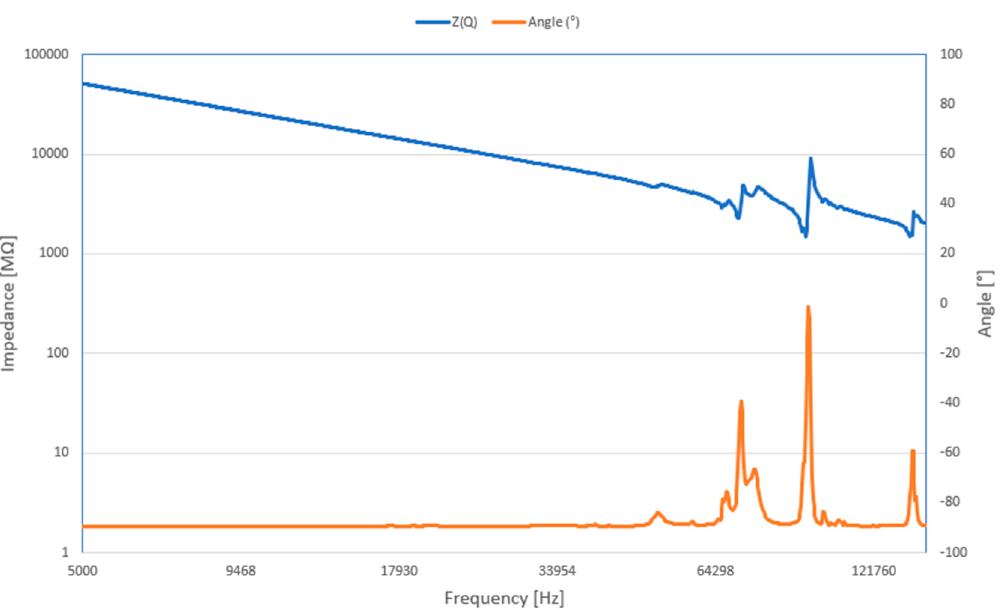
Figure 13. An impedance and phase angle measurement results of piezoelectric transducer, when signal driven electrode is connected.